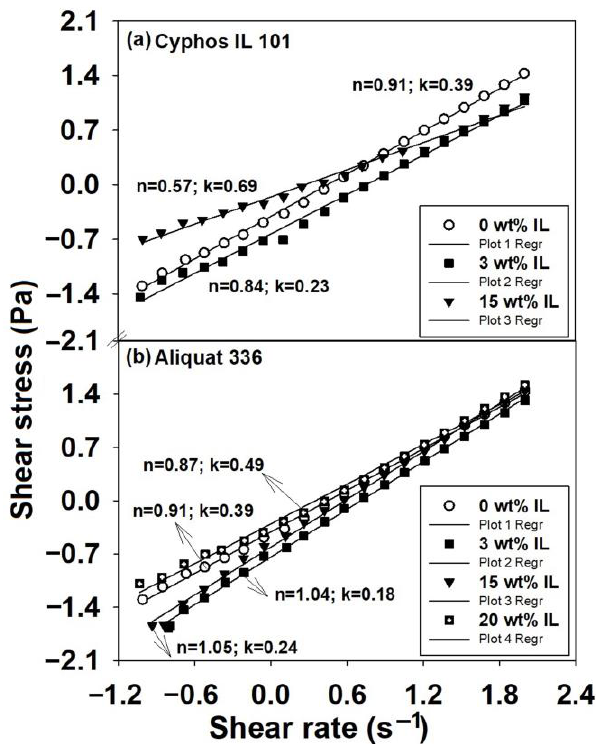
Figure 3. Ostwald–Waele model represented by double—logarithmic plots of shear stress versus shear rate for studied systems PSFQ/Cyphos IL 101 ( a ) and PSFQ/Aliquat 336 ( b ) at various mixing ratios and 25 °C.